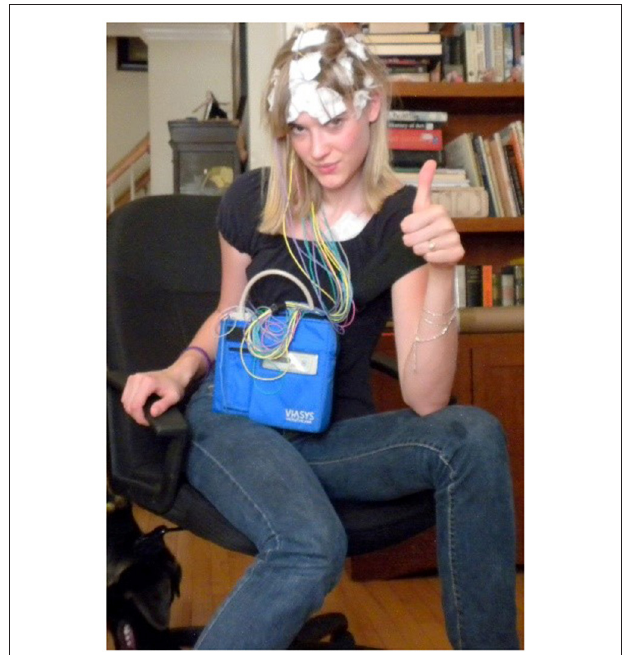
FIGURE 1 | Typical wired ambulatory EEG (with permission from Kelly Falk).